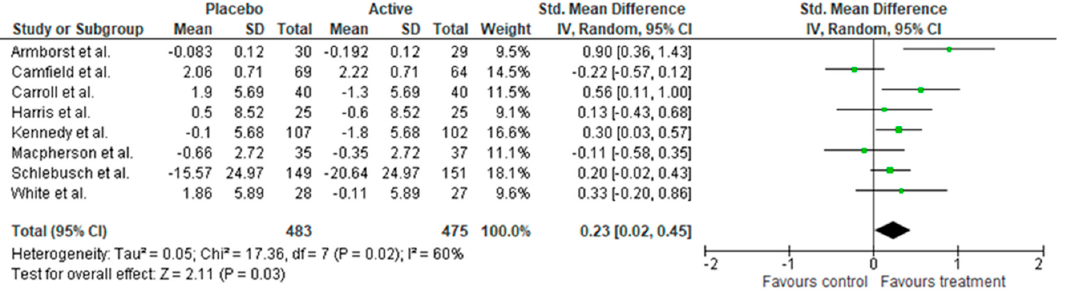
Figure 3. Forest plot of meta-analysis on stress symptoms.